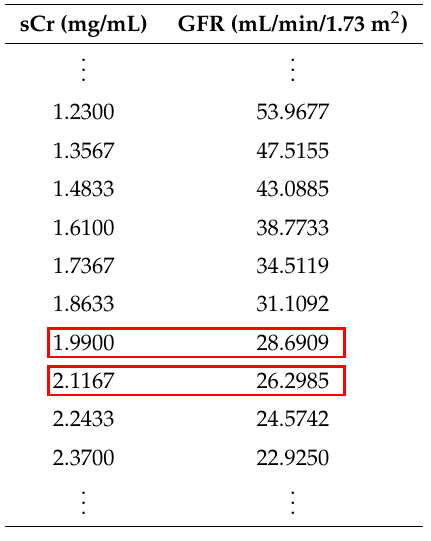
Table 5. Portion of a numerical model obtained on the adult patients sCR/GFR dataset. Two rows enclosed in a red box represent two data-pairs used in the interpolation of the reading sCR (cid:63) = 2.02 in the Example